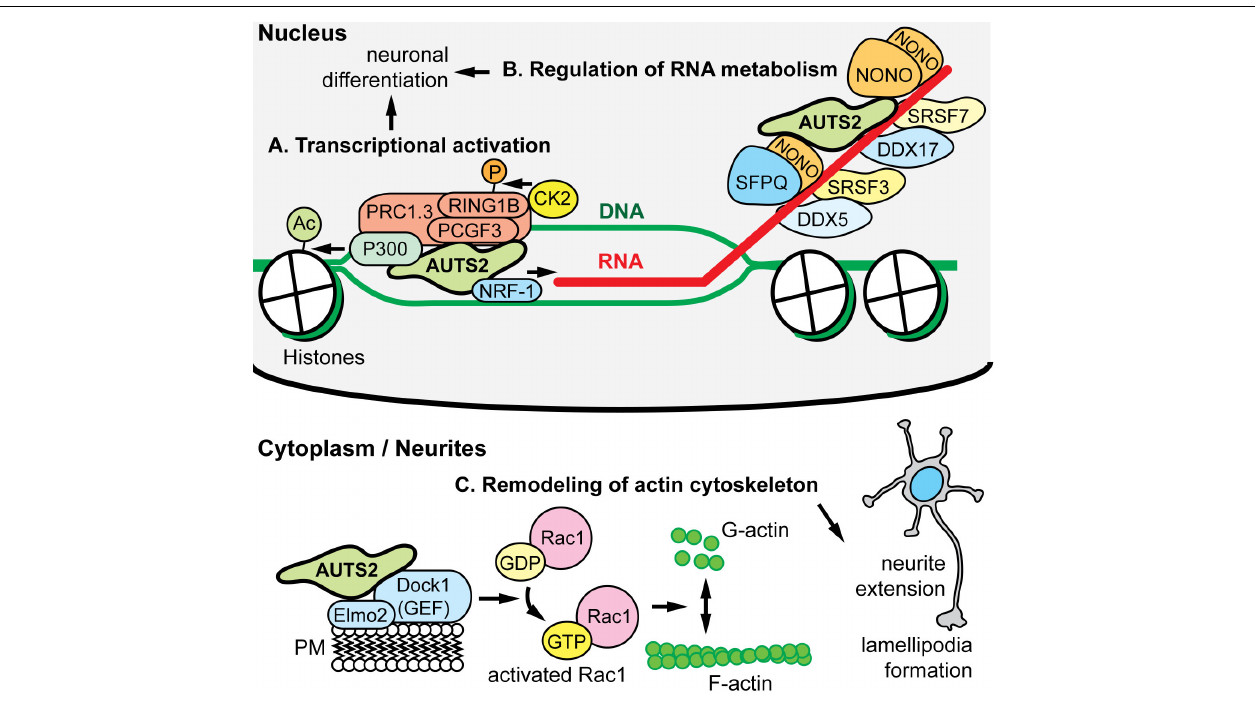
FIGURE 3 | AUTS2 molecular functions and interactions. (A) In HEK293 cells, AUTS2 associates with variant forms of polycomb repressive complex 1 (vPRC1), which also contains PCGF3/5, RING1B, and other PRC1 subunits (PMID: 25519132). In turn, AUTS2 recruits P300, a histone acetyltransferase that opens chromatin, and binds NRF1, a transcriptional activator (PMID: 34637754). Also, vPRC1 recruits CK2, a protein kinase that phosphorylates and inactivates RING1B, a ubiquitin ligase and core subunit of PRC1 for chromatin inactivation. The net effect of AUTS2 is to convert PRC1 from a repressor to an activator of transcription. (B) In developing cerebral cortex, AUTS2 associates with multiple RNA-binding proteins (RBPs), including the scaffolds NONO and SFPQ; splicing factors SRSF3 and SRSF7; and RNA helicases DDX5 and DDX7 (PMID: 34013328). Also, AUTS2 co-immunoprecipitated multiple RNA species, suggesting that AUTS2 binds RNA directly or indirectly. (C) In HEK293 cells, AUTS2 associates with a guanine nucleotide exchange factor (GEF) complex containing DOCK1 (also known as DOCK180) and ELMO2 (PMID: 25533347). Through this interaction, AUTS2 is thought to cause activation of Rac1 (a small G protein), remodeling of the cytoskeleton, neurite elongation, and lamellipodia formation. AUTS2 was also found to interact with another GEF, P-REX1; and may regulate multiple small G